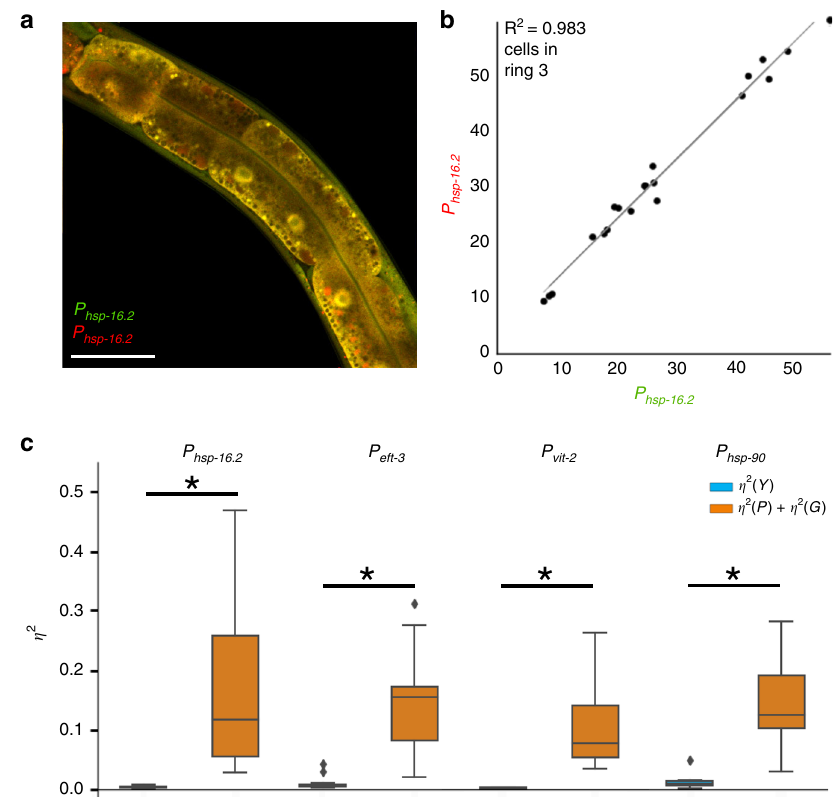
Fig. 2 Type I experiments reveal low intrinsic noise. a An example of the animal producing fl uorescent reporters (mEGFP and mCherry) from two identical promoters ( P hsp-16.2 ); white scale bar on bottom right is 50 μ m. We did not observe patchwork of green and red cells. Cells were nearly uniformly yellow, indicating low intrinsic noise. b Scatterplot of P hsp-16.2 ::GFP and P hsp-16.2 ::mCherry expression in cells in ring three of the intestine from ten animals examined in one experiment. c . Boxplots show correlated and uncorrelated variations for P hsp-16.2 , P eft-3 , P vit-2 , and P hsp-90 in the intestine cells in rings 1 – 4. y axis is unitless η 2 ; see Supplementary Note 4 for a detailed description of how to calculate intrinsic noise. The boundary of the box closest to zero indicates the 25th percentile, a line within the box marks the median, and the boundary of the box farthest from zero indicates the 75th percentile. Whiskers above and below the box indicate the 90th and 10th percentiles. Outliers are shown as diamonds. In type I experiment uncorrelated variation arises from stochastic noise of transcription/translation or variable allele access — η 2 ( γ ) (colored red as in Fig. 1); correlated variation is a combined result of variation in gene expression capacity η 2 (G) and variation in pathway activation η 2 (P) (colored orange to represent a combination of the two terms from Fig. 1). Asterisks indicate statistical signi fi cance of p < 0.05 by two-tailed t -test. For each pair of alleles, data are from three independent experiments measuring intestine cells from thirty animals in three independent experiments (intestine cells from ten animals were measured in each experiment for each allele signal convoluted by abstract spatial patterns and auto- fl uorescence. Therefore, we chose to quantify proteins that loca-